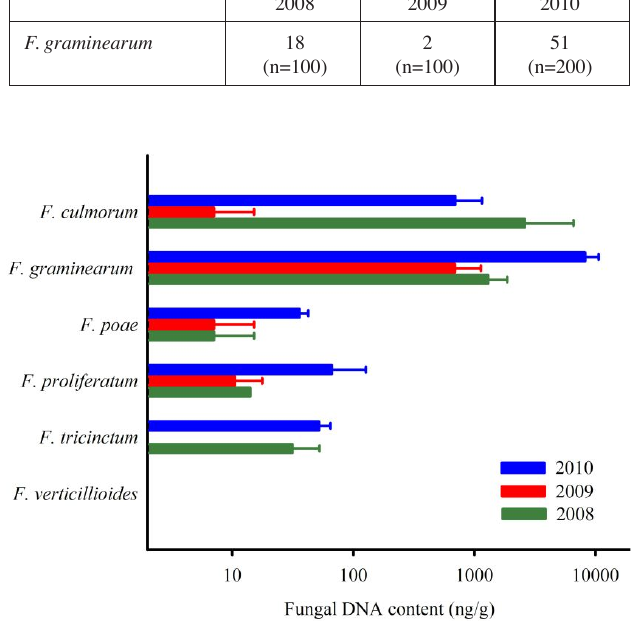
Fig. 2: Fusarium DNA in naturally infected durum wheat kernels